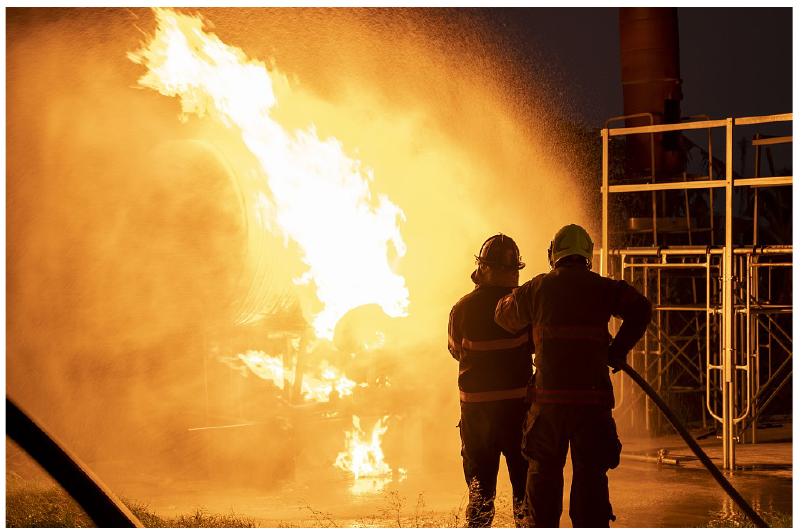
Figure 8. Emergency rescue teams: firefighting equipment (picture source: [23]).